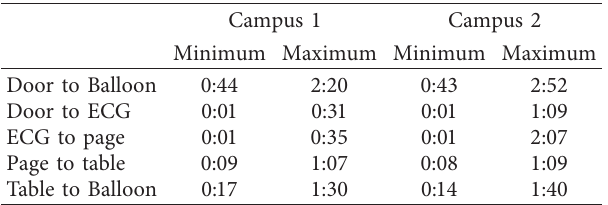
Door to Balloon Page to table Table to balloon Times are reported as hours:minutes:seconds. Table 5: Minimum and maximum times for Campus 1 and Campus 2.